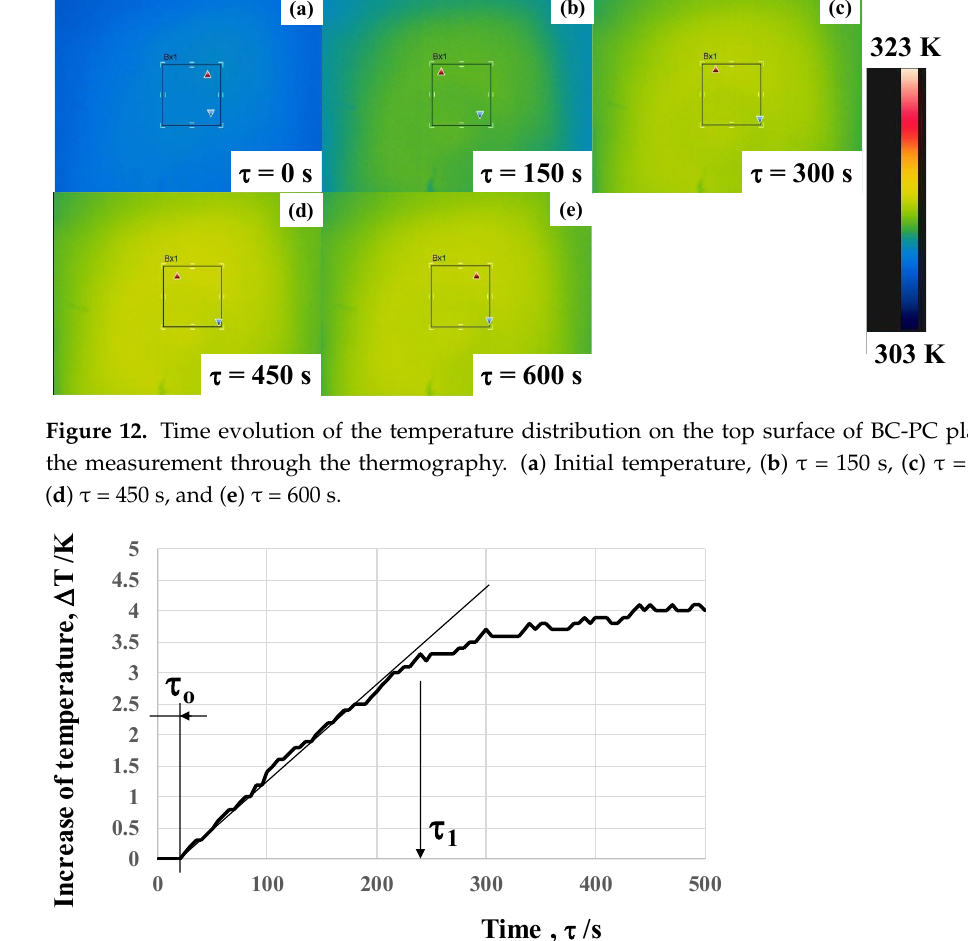
Figure 13. Variation in the maximum temperature at the focused center point in BC-PC with time by the heat radiation process.